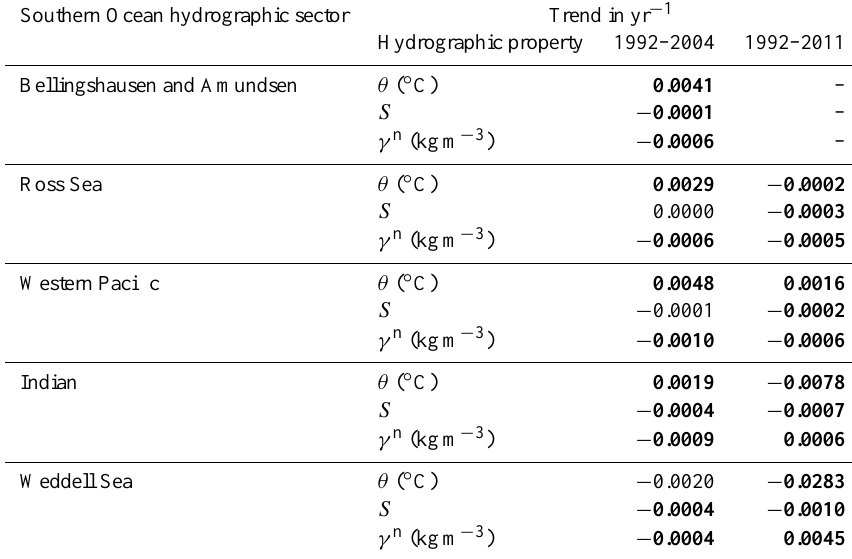
Table 2. Linear fits of the annual regional AABW time series based on the ECCO2 output a